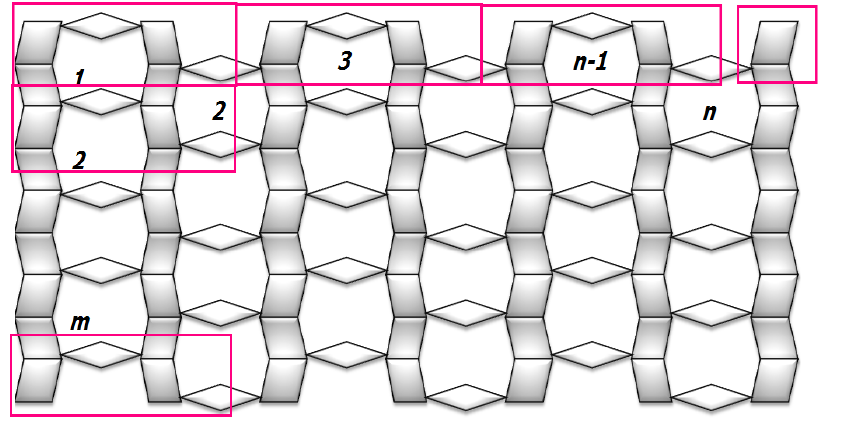
Fig. 1 2-dimensional model to Titania nanotube TiO 2 [m,n]